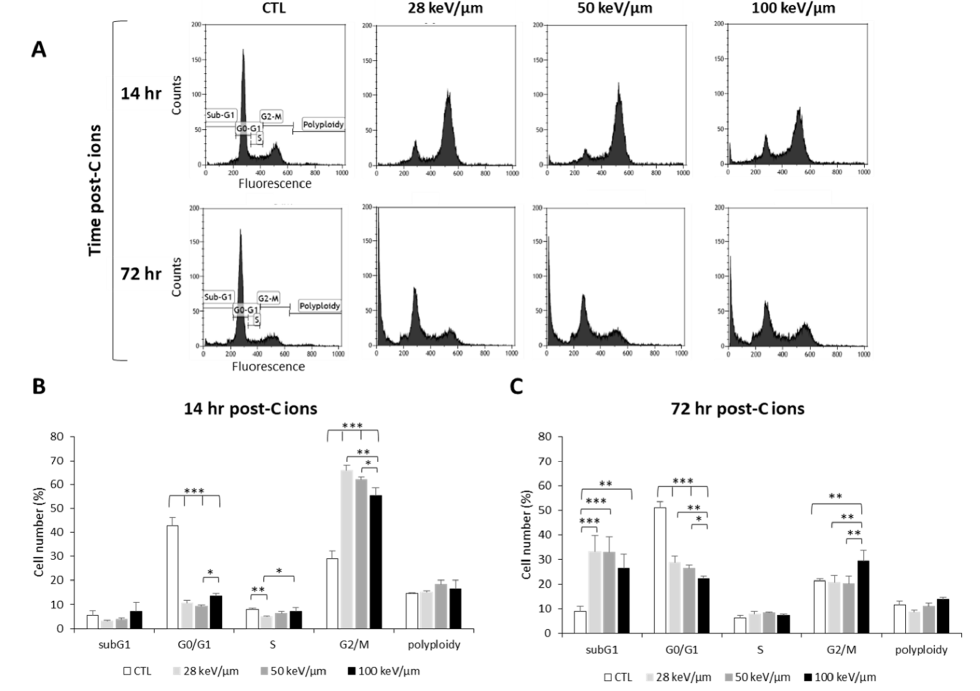
Figure 2. Effect of carbon ion irradiation on the cell cycle of U251 glioblastoma cells. ( A ) Cell cycle profiles of U251 cells exposed under normoxia (21% O 2 ) to carbon ions (4 Gy) with various LET (28, 50, and 100 keV/µm) assessed at 14 h and 72 h after irradiation; ( B ) Quantification of the cell distribution in the different phases of the cell cycle at 14 h and ( C ) at 72 h after carbon ion treatment. Mean ± SD, N = 3 different experiments for both irradiation conditions. Fisher’s LSD post-hoc test after significant one-way ANOVA; * p < 0.05, ** p < 0.01, and *** p < 0.0001.